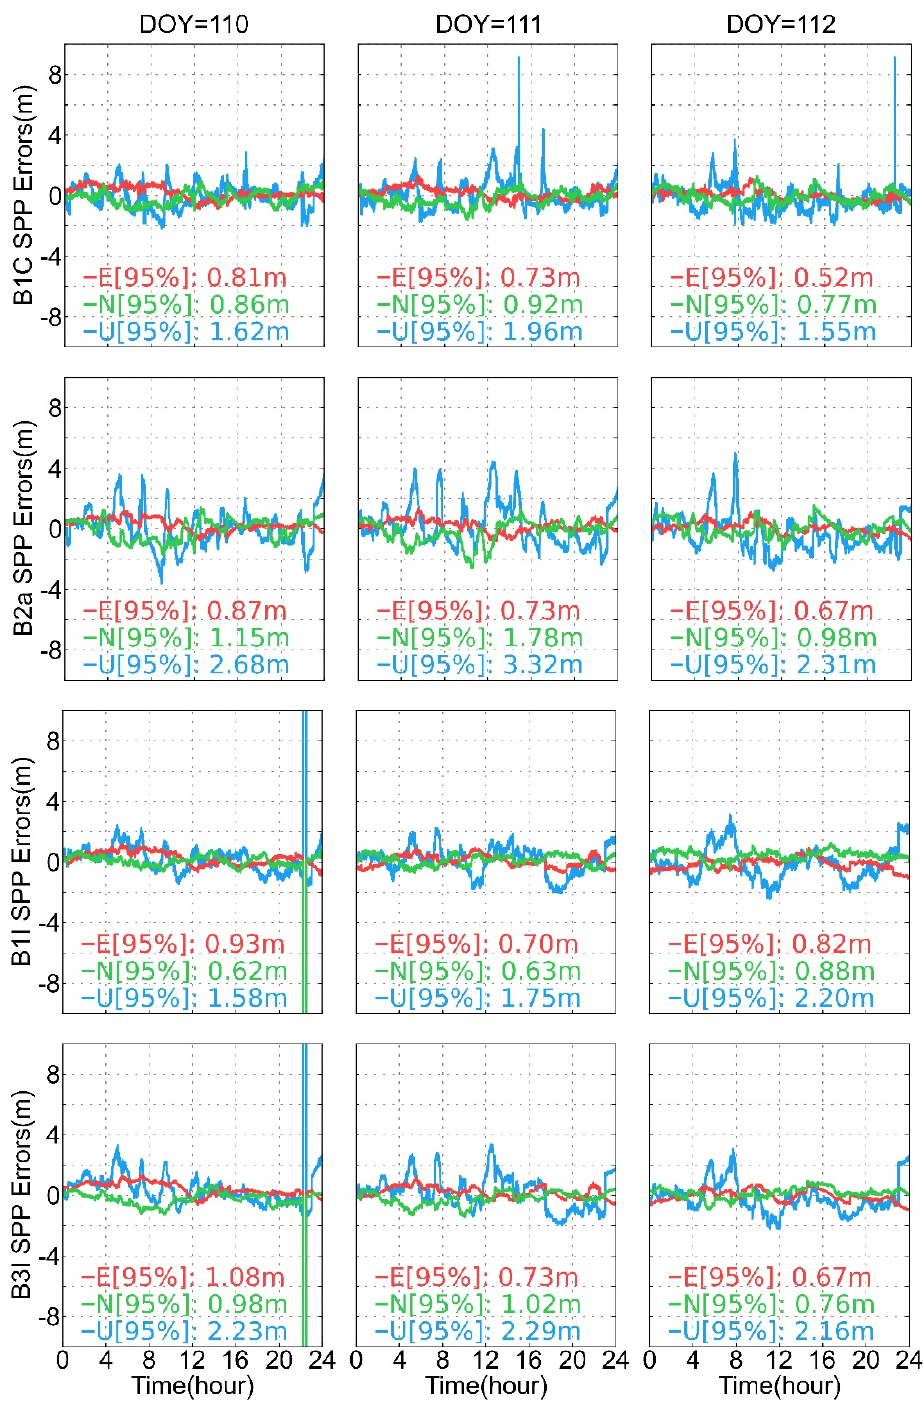
Figure 10. The time series of SPP errors at the station GUA1 before ( left column ), during ( middle column ) and after ( right column ) the day on which geomagnetic storm occurred. The four rows of panels represent the signals of B1C, B2a, B1I and B3I from top to bottom. In each panel, the time series and statistics corresponding to the directions of east (E), north (N) and up (U) are displayed in red, green and blue, respectively.